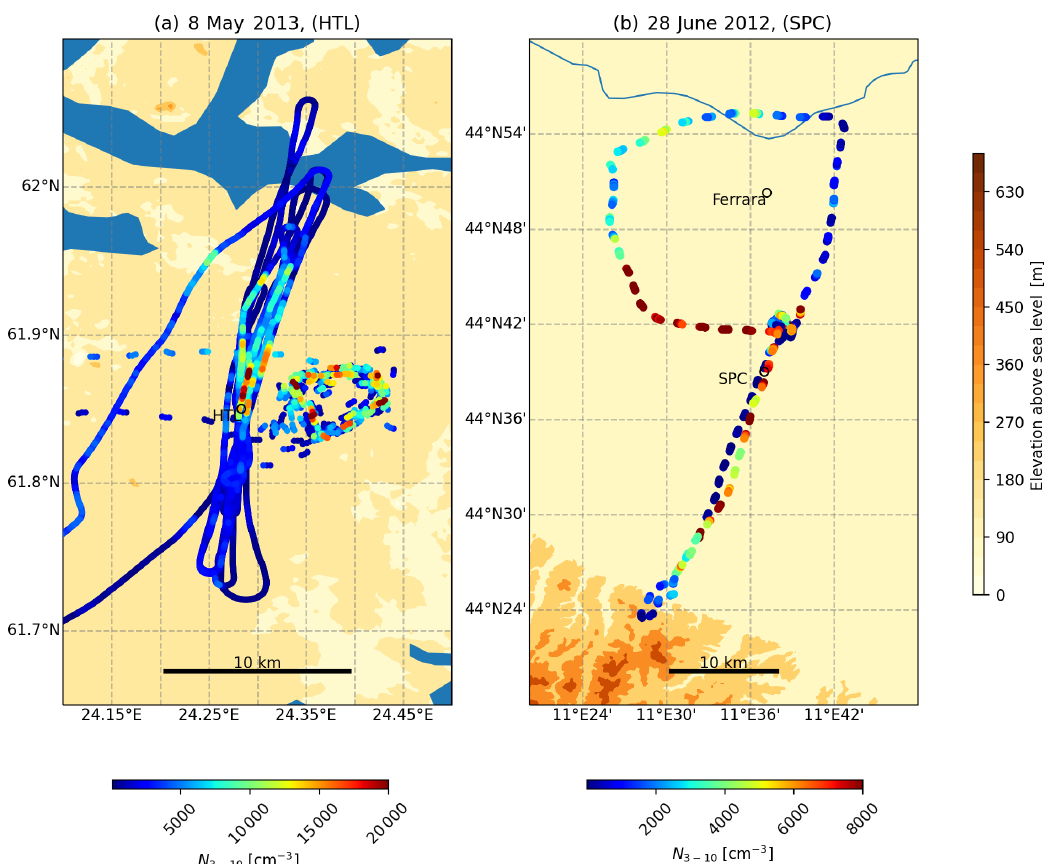
Figure 8. (a) The flight tracks of the Zeppelin (circular track) and the airplane (track with back and fourth segments) colored by 3–10nm par- ticle number concentration from HTL on 8 May 2013. (b) The flight track of the Zeppelin colored by 3–10nm particle number concentration from SPC on 30 June 2012. The Zeppelin flight track has gaps, because the NAIS was measuring in the ion mode during that